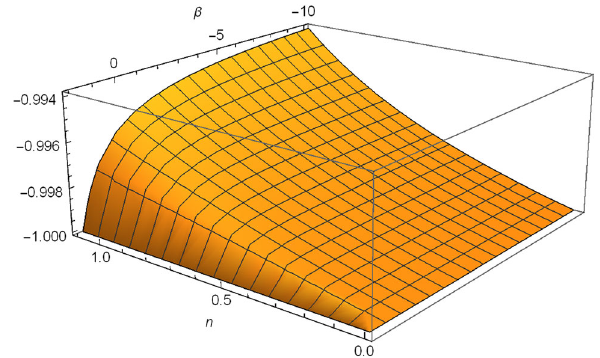
Fig. 6 The figure shows the behavior of the EoS parameter (vertical axis). We use the ranges n = [ 0 , 1 . 1 ] and β = [− 10 , 2 ] with the values γ = 0 . 018, N =